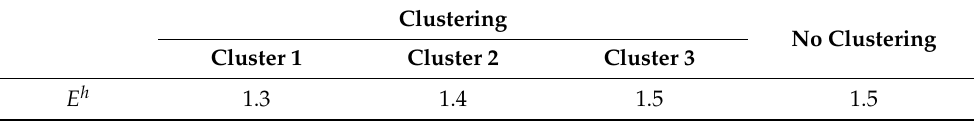
Clustering Cluster